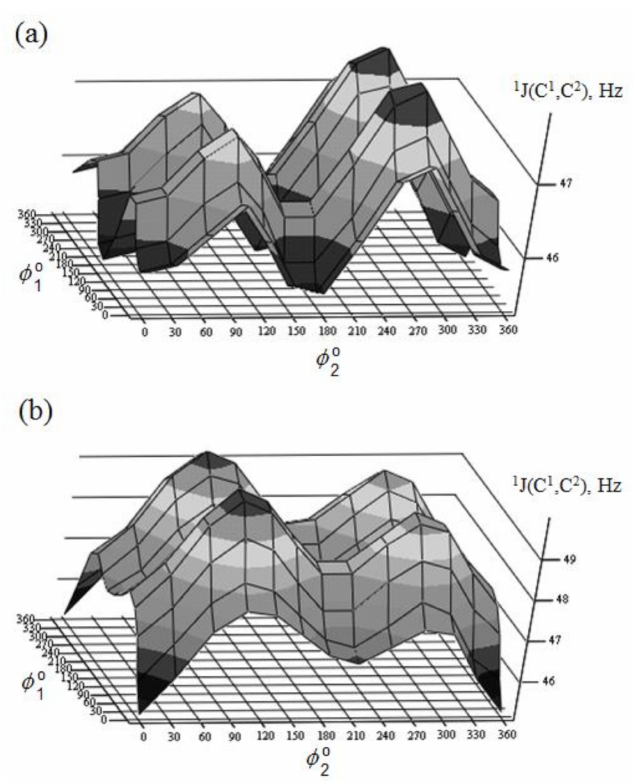
Figure 29. Rotational surface of 1 J (C-1,C-2) of ( a )— α -D-mannofuranose and ( b )— β -D-mannofuranose. Reproduced from the PhD Thesis by Danilova [136].